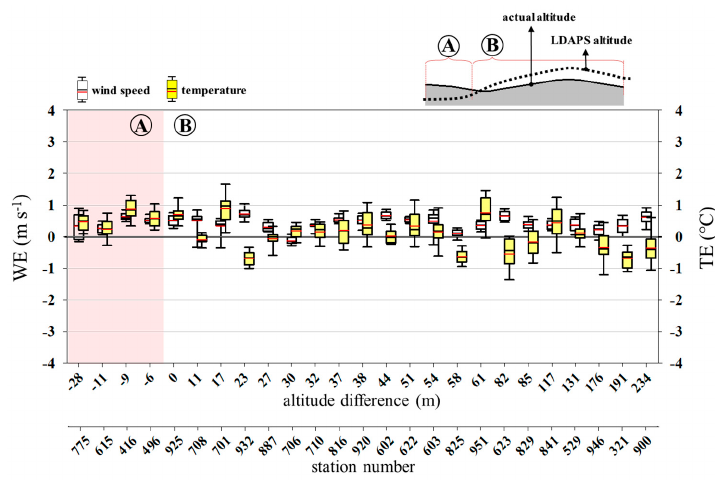
Figure 5. Scatter plots of the AWS-observed and LDAPS-predicted temperatures (left panels) and wind speeds (right panels) at the ( a , b ) AWS 403 (installed on a building roof and ( c , d ) AWS 410 (installed on the ground level). Red and blue dots indicate for summer season (June, July, and August) and winter season (December, January, and February), respectively.